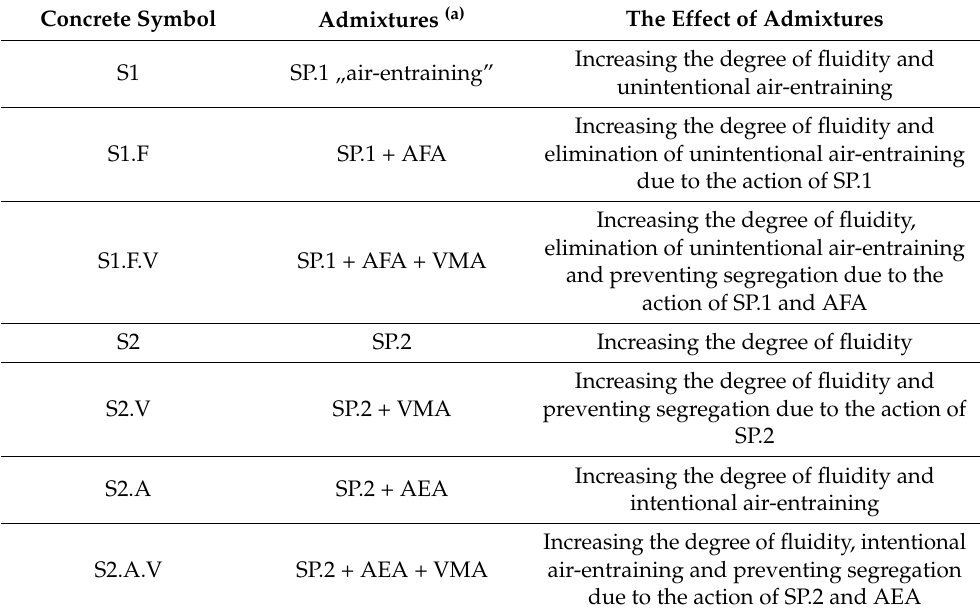
Table 2. Tested concretes, types and effects of admixtures used.